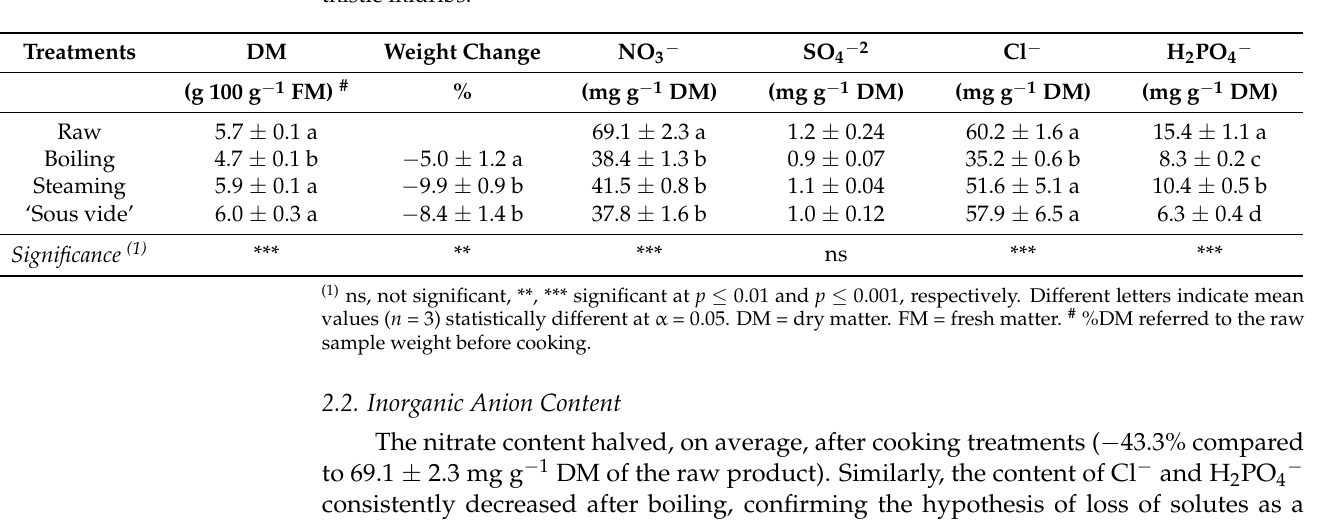
Table 1. Dry matter, weight change, and inorganic anion content in raw and cooked golden thistle